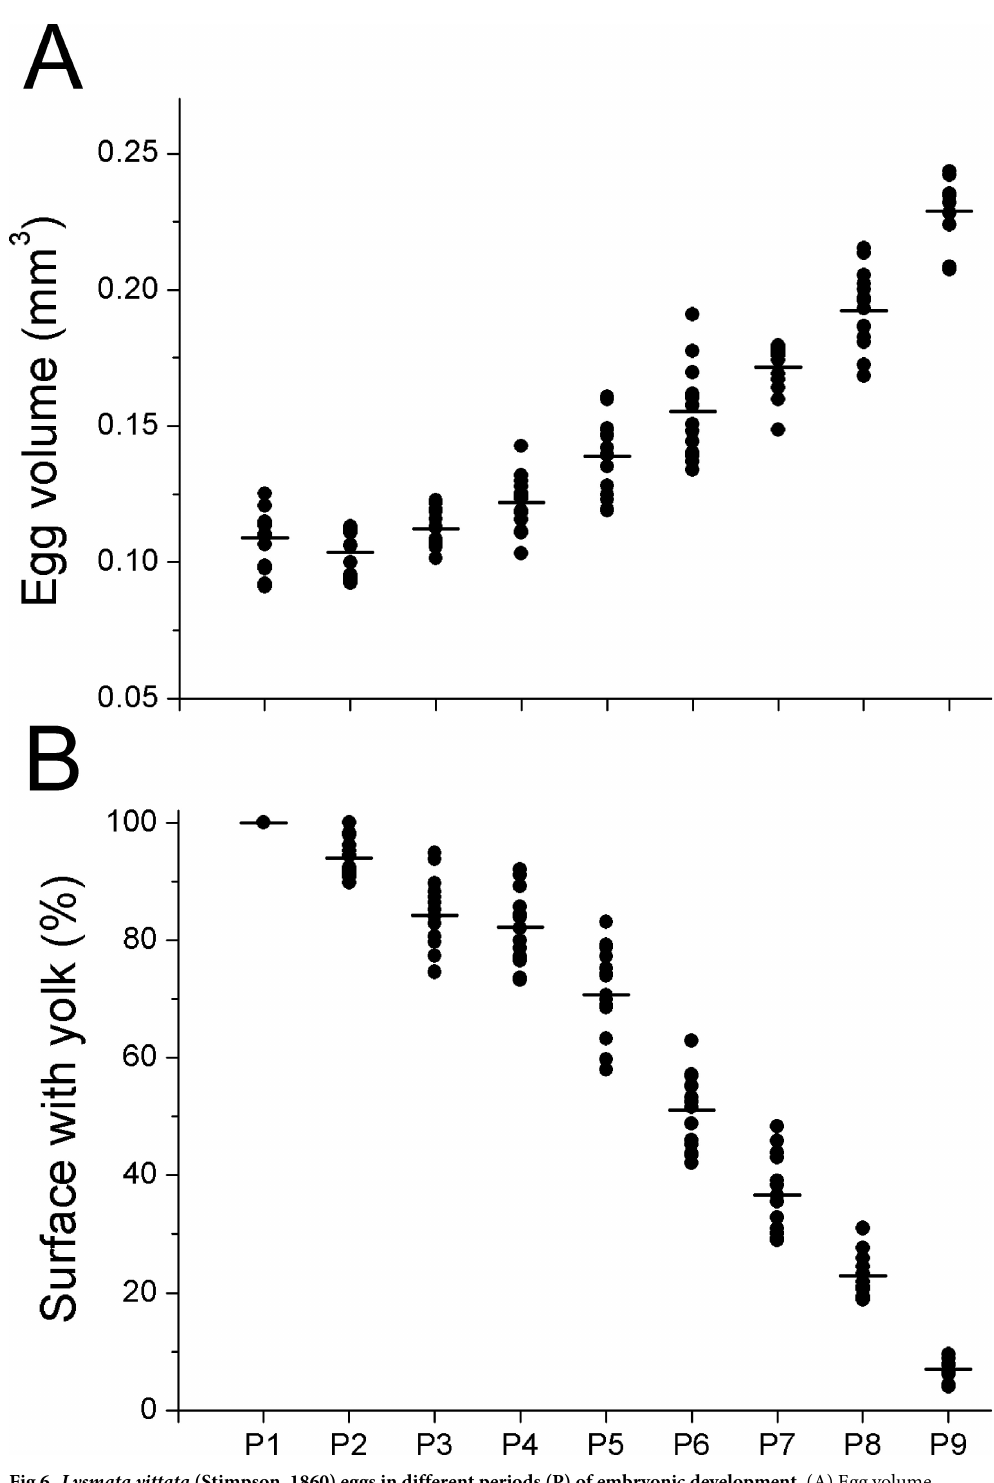
Fig 6. Lysmata vittata (Stimpson, 1860) eggs in different periods (P) of embryonic development. (A) Egg volume (mm 3 ). (B) Surface with yolk (%). Bars ( ― ) indicate mean values.